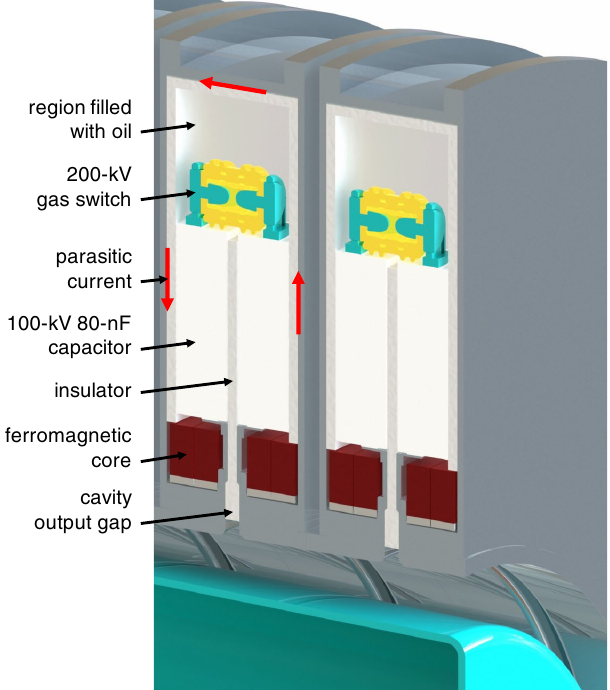
FIG. 2. Cross-sectional view of two LTD cavities. The red arrows indicate the path of parasitic current that flows along the inner surfaces of the walls of each cavity. This current creates a magnetic field within each cavity that diffuses into the ferro- magnetic cores and changes their magnetization state. Hence energy is lost to the cores through magnetic-energy diffusion and Ohmic heating. Since the cores absorb energy from the parasitic current, the cores introduce an effective resistance in the path of this current, which reduces its